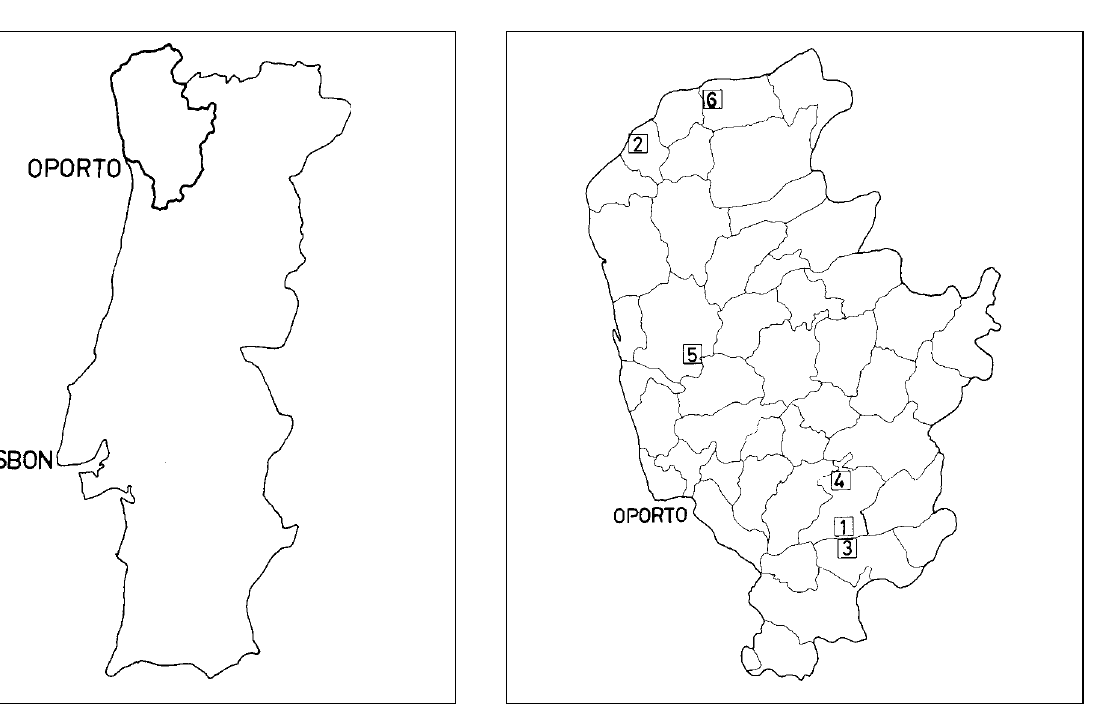
Fig. 2. Map of the region of Vinho Verde with the loca- tions of sampling sites.